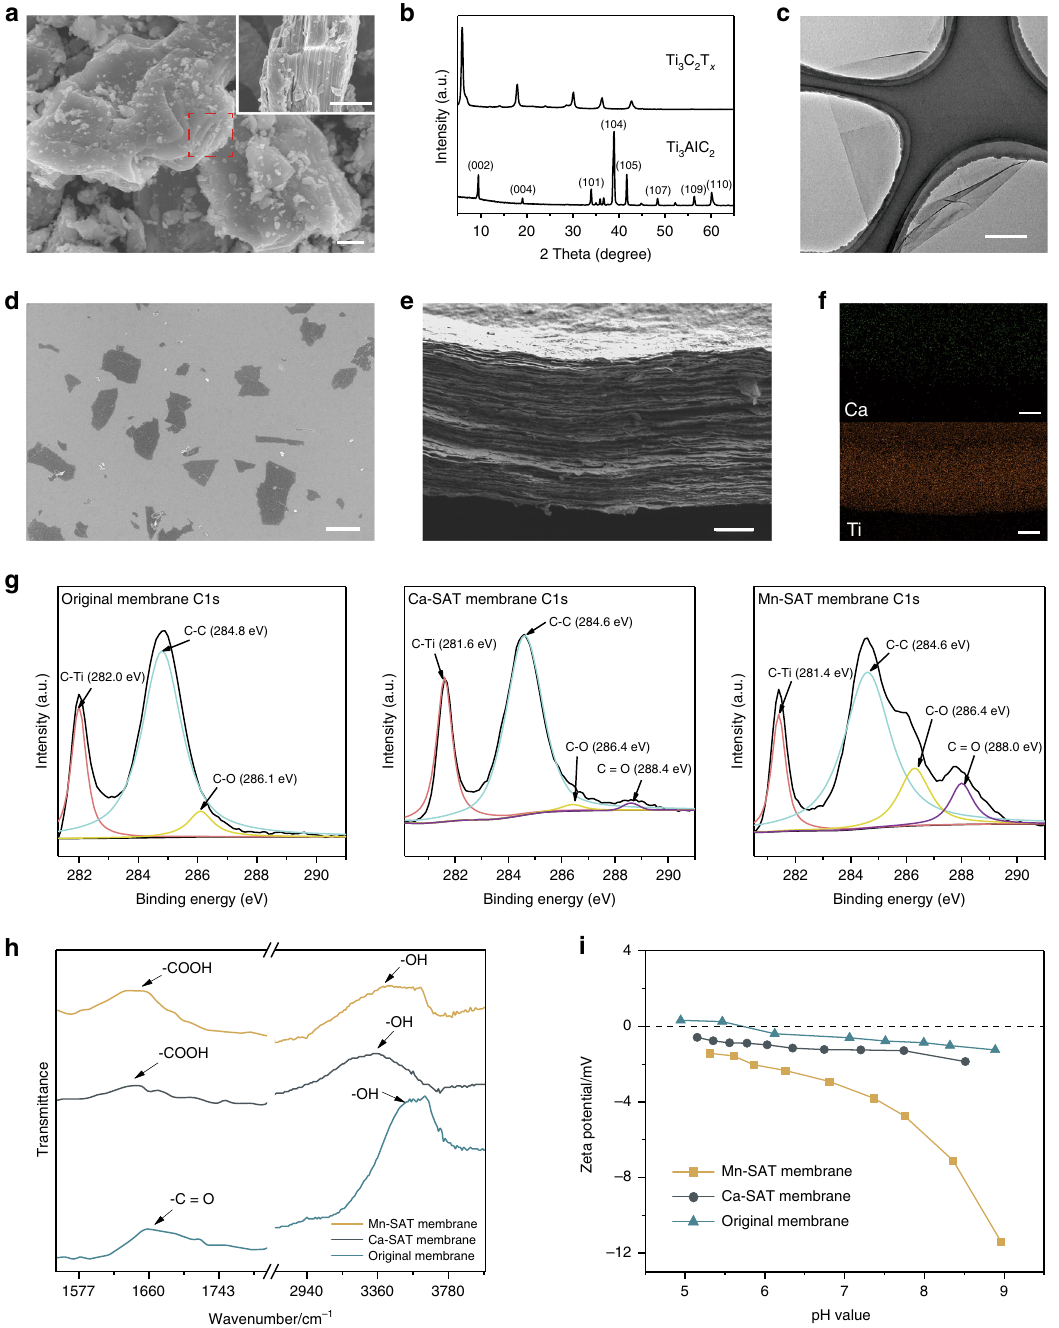
Fig. 2 Characterizations of Ti 3 C 2 T x nanosheets and Ca-SAT membranes. a SEM image of the MAX phase Ti 3 AlC 2 powder (scale bar is 2 μ m). b XRD patterns of the Ti 3 AlC 2 powder and the Ti 3 C 2 T x nanosheets. c TEM image of a monolayer Ti 3 C 2 T x nanosheet (scale bar is 500 nm). d SEM images of the Ti 3 C 2 T x nanosheets deposited on the silicon substrate (scale bar is 1 μ m). e SEM image of a cross-section of the Ca-SAT membrane (scale bar is 1 μ m). f EDS elemental maps of the Ca-SAT membrane (scale bar is 1 μ m). g C 1 s XPS spectra with the fi tting results of the original and pillared Ti 3 C 2 T x membrane. h FTIR spectra of the original and pillared membranes. i Surface zeta potentials of the original and pillared